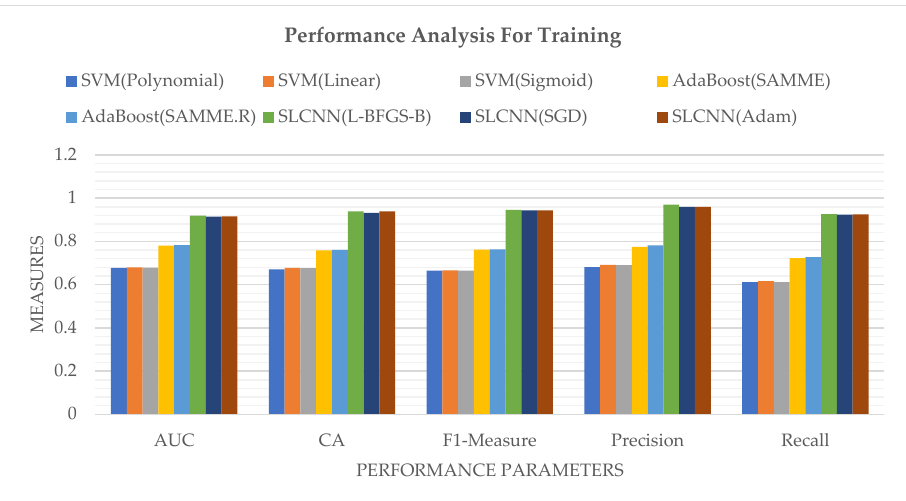
Figure 9. Performance Analysis of SVM, AdaBoost, and SLCNN. Table 7 indicates the implementation time and the prerequisite of classification tech- niques for text-based sentimental classification from the Guardian dataset. Table 7. Execution Time of the Guardian Dataset Analysis for Text-Based Sentimental Classification.